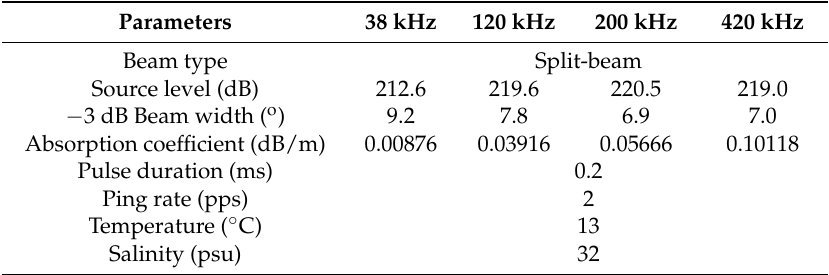
Table 1. Several scientific echo-sounder parameters used for the target strength ( TS ) measurements of Redlip mullet ( Chelon haematocheilus